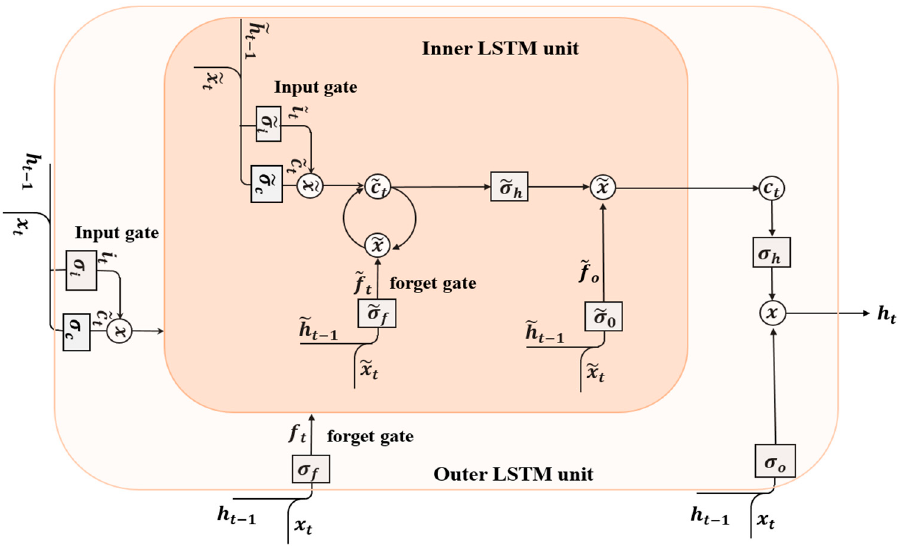
Figure 6. Functional Block diagram of NLSTM.